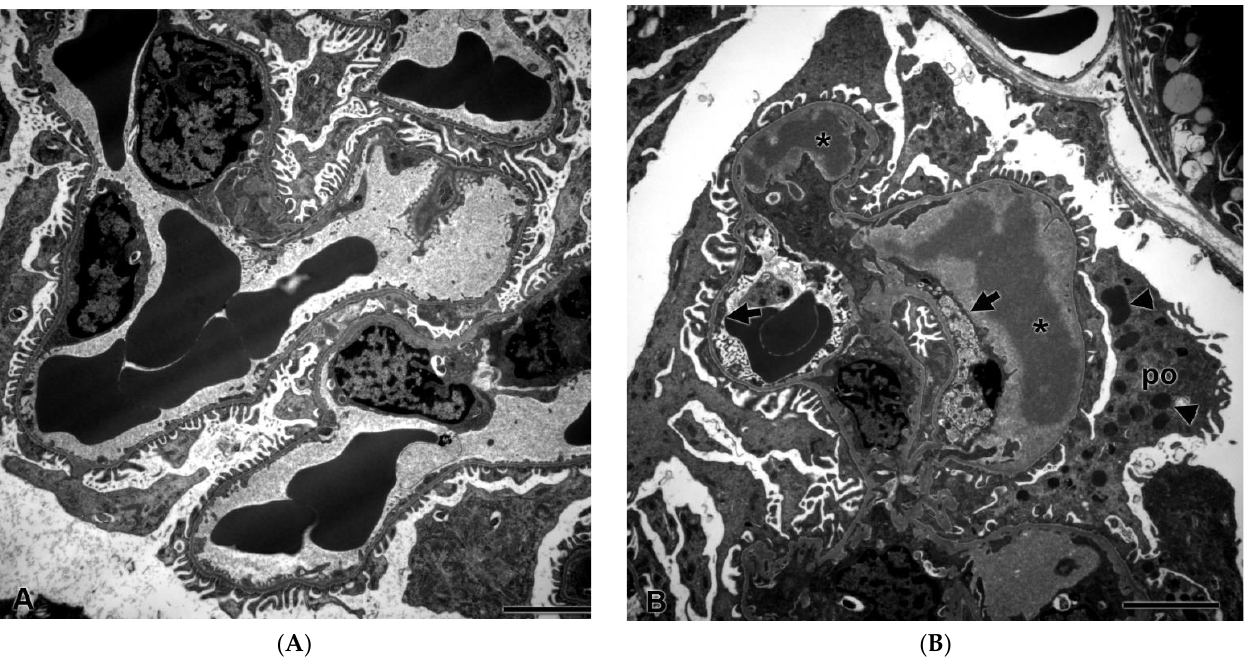
Figure 4. Glomerular ultrastructural changes in rats treated with vehicle control ( A ) and ABT-123 at 10 mg/kg/day ( B ) for seven days. Rats treated with ABT-123 showed irregularly shaped foot processes of podocytes (po), loss of fenestrations in endothelium (arrow), and electron-dense deposits (stars) or granules (triangle) in subendothelial space and in podocytes, respectively. Scale bar = 2 μ m.